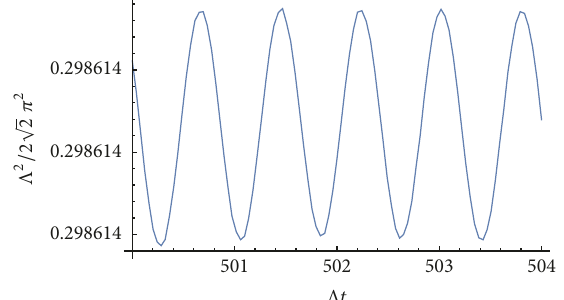
Figure 3: 𝐺 푅 (0,𝑡) derived by numerical calculation when 𝑡 goes larger. The oscillation of 𝐺 푅 (0,𝑡) can be seen clearly when 𝑡 is large.